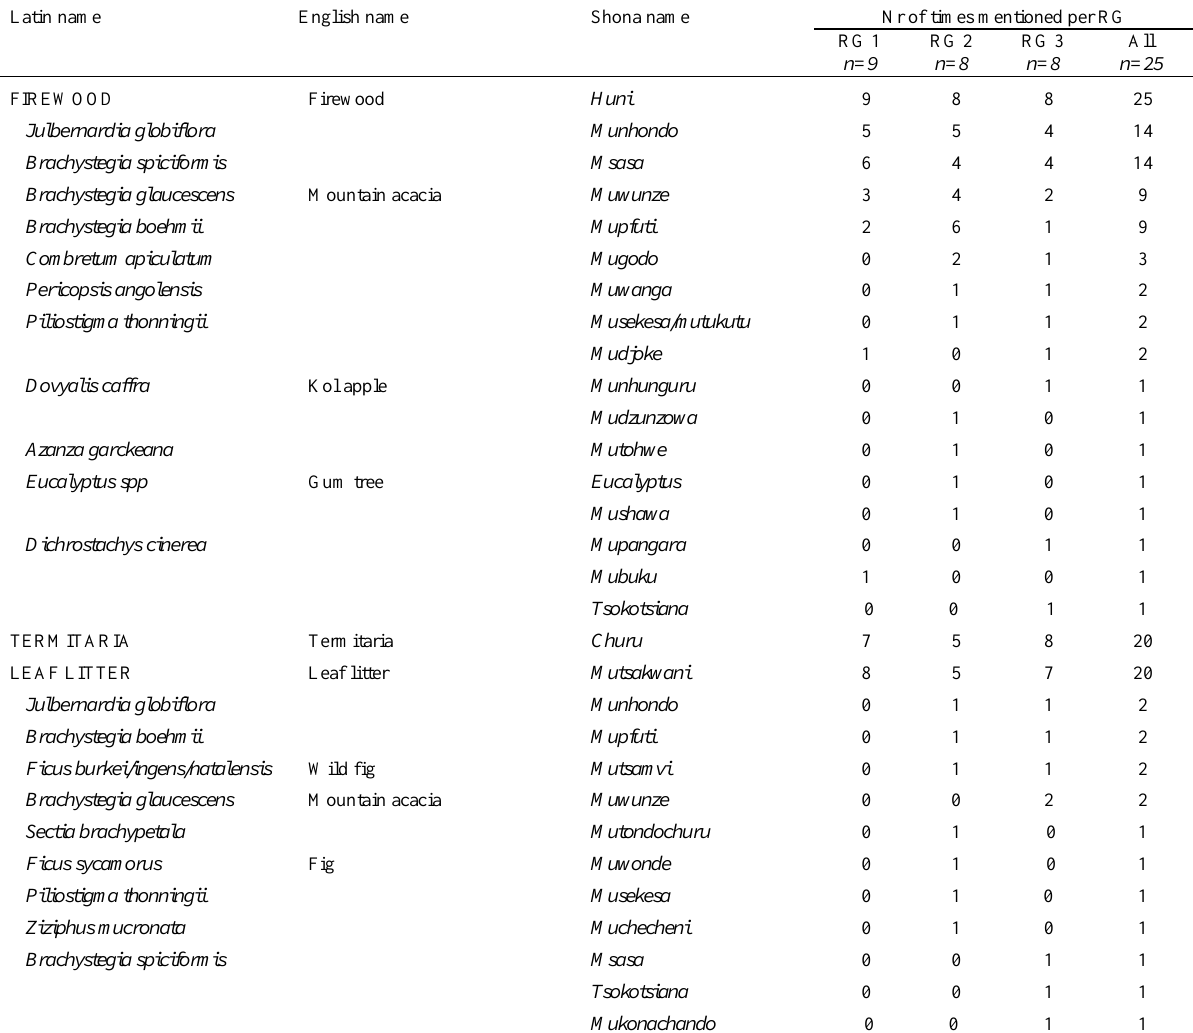
Table A3.9: Non-food products, species names and collection scores. Latin